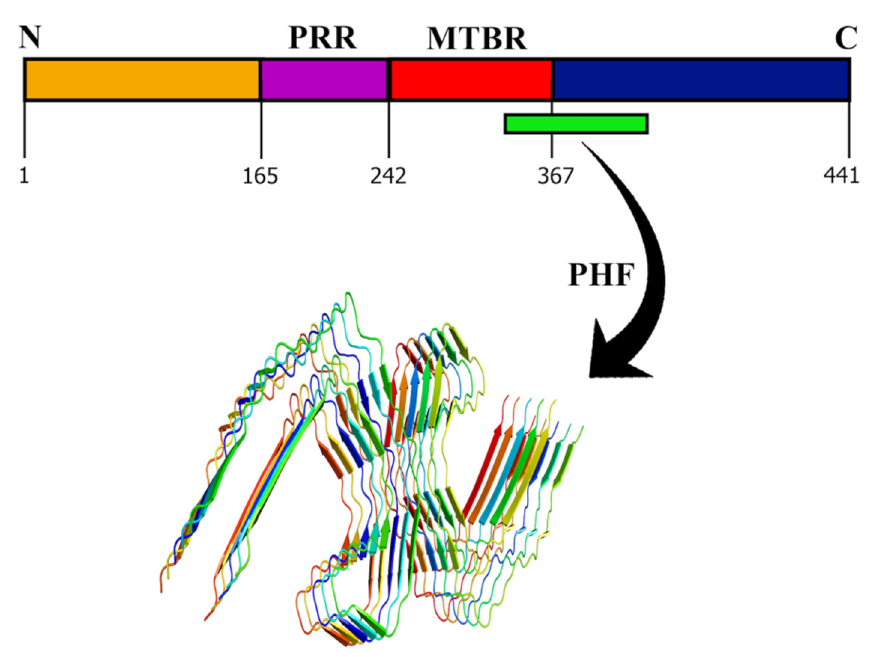
Figure 3. Domain structure of tau protein. The N-terminal domain, proline-rich region (PRR), microtubule-binding region (MTBR), and C-terminal region (CTD) are shown. The PHF aggregate from 308–380 amino acids (in green) of tau protein solved by cryo-EM (PDB ID: 7NRQ) [91] shows the assembly of tau in the diseased fibril phase.